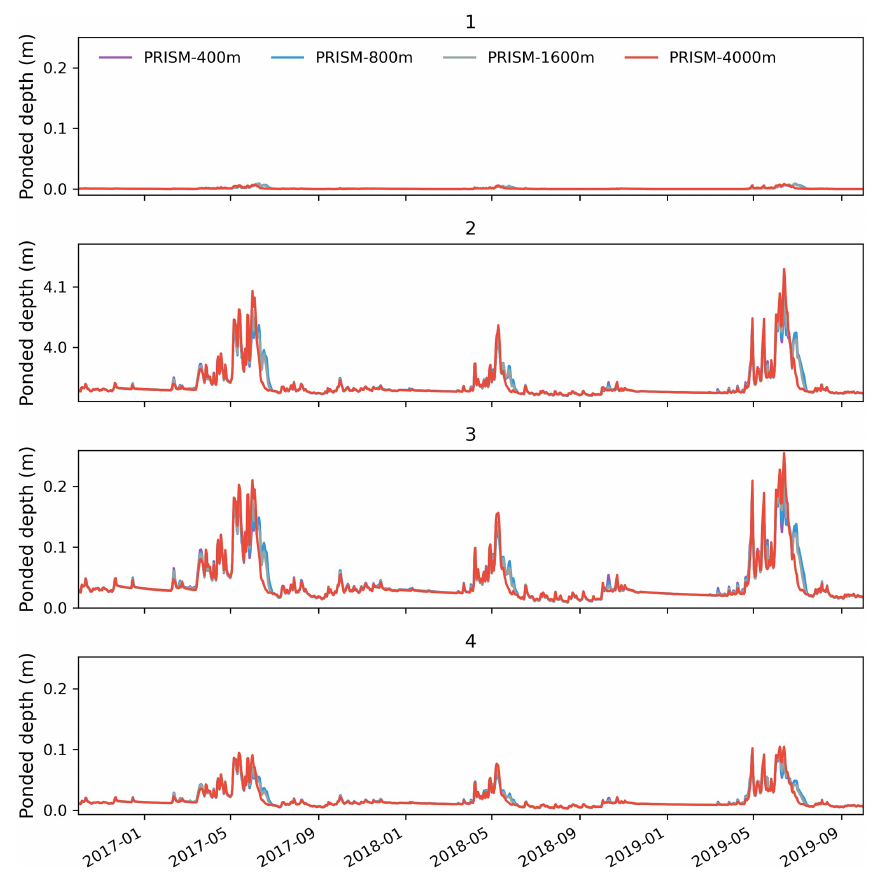
Figure 12. Simulated surface ponded depth at four selected locations under different spatial resolutions of